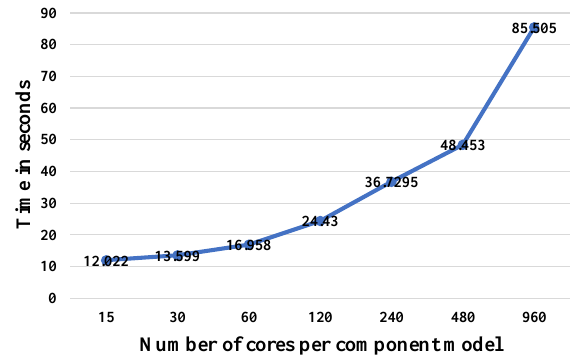
Figure 8. Initialization cost for coupling two trial models with C- Coupler2 on a supercomputer with Intel Xeon CPUs and an Infini- Band network.